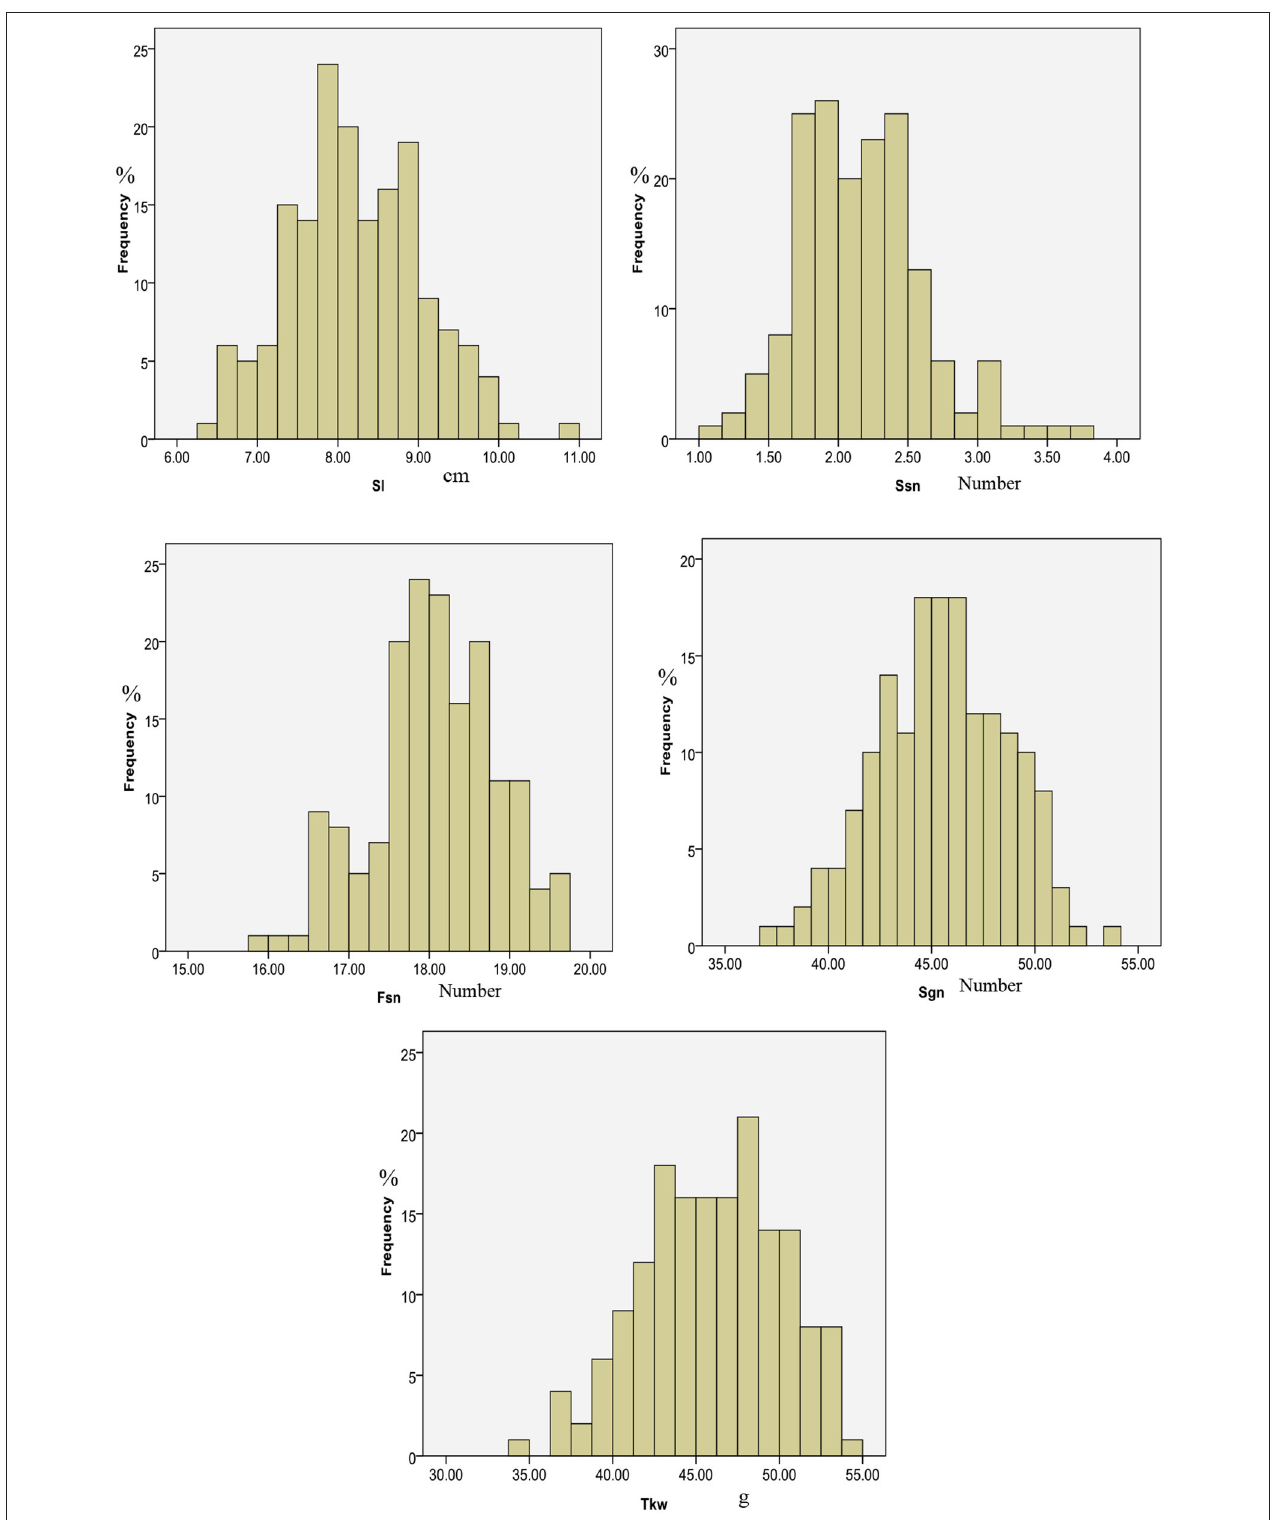
FIGURE 1 | Distributions of five spike-related traits based on average data from four different treatments in two locations and 2 years.